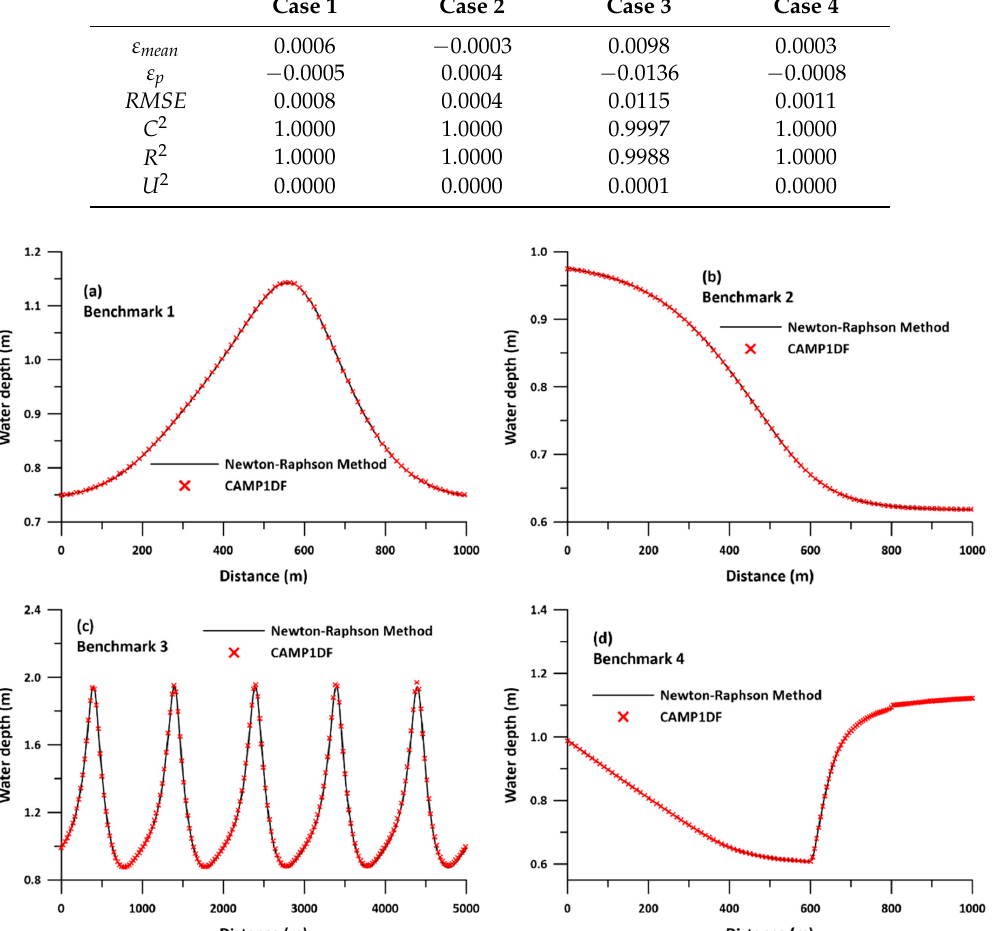
Figure 5. Calibration result of KIW of ( a ) benchmark 1, ( b ) benchmark 2, ( c ) benchmark 3, and ( d ) benchmark 4 of MacDonald et al. (1997) [30].